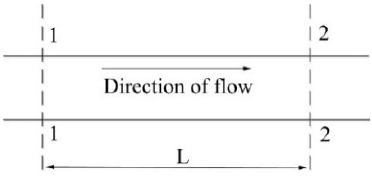
Figure 4. Locations of Cross-section 1-1 and Cross-section 2-2 along the pipe.